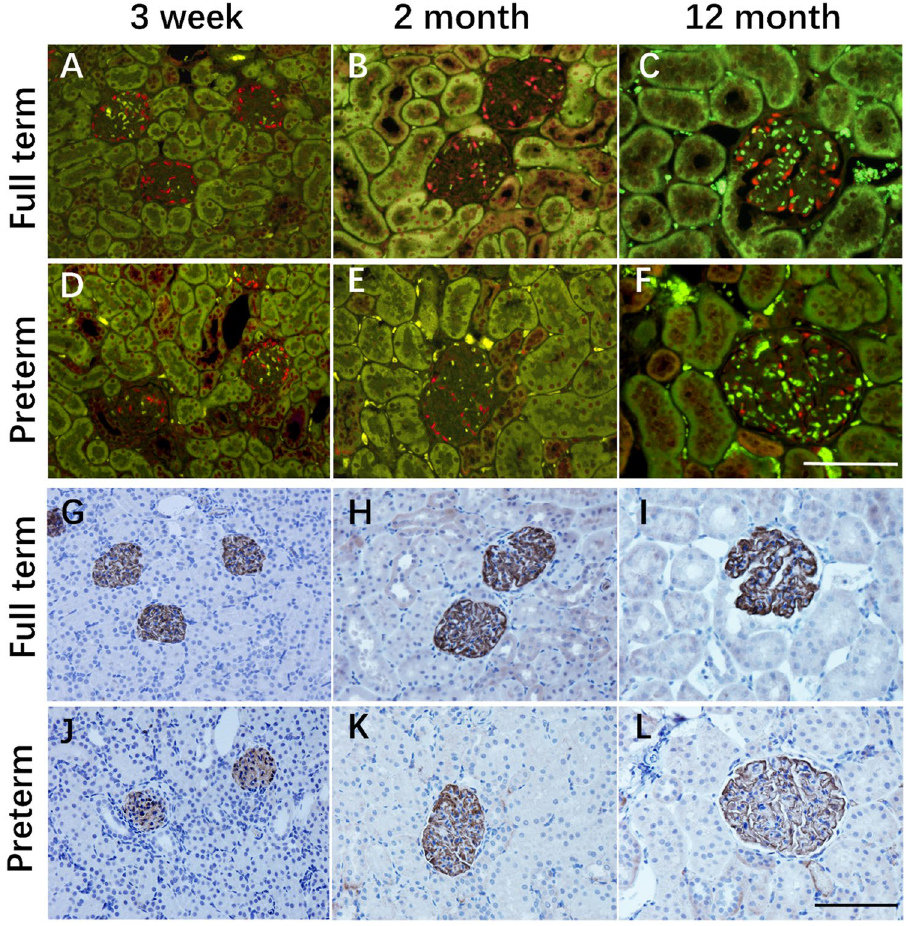
Figure 4. Time course of podocyte density presented by two independent methods in full-term and preterm rats. The upper two lines ( A – F ) show WT1-stained podocyte nuclei (red). The lower two lines ( G – L ) show SYNPO peroxidase-stained podocyte cell bodies in the same sections. The first and third lines ( A – C , G – I ) show glomeruli from full-term rats, while the second and fourth lines ( D – F , J – L ) show glomeruli from preterm rats. The left column illustrates glomeruli from 3 weeks of age ( A , D , G , J ). The middle column illustrates glomeruli from 2 months of age ( B , E , H , K ), and the right column shows glomeruli from 12 months of age ( C , F , I , L ). Both the podocyte nuclei density and podocyte cell bodies were reduced in the preterm rats. More detailed podometric parameters from these three time points are presented in Fig. 5. Bar = 100 µm.